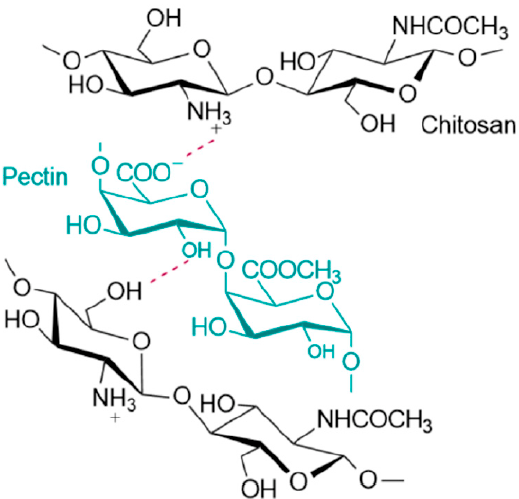
Figure 4. Representation of the intermolecular forces among Ch and Pec polymers